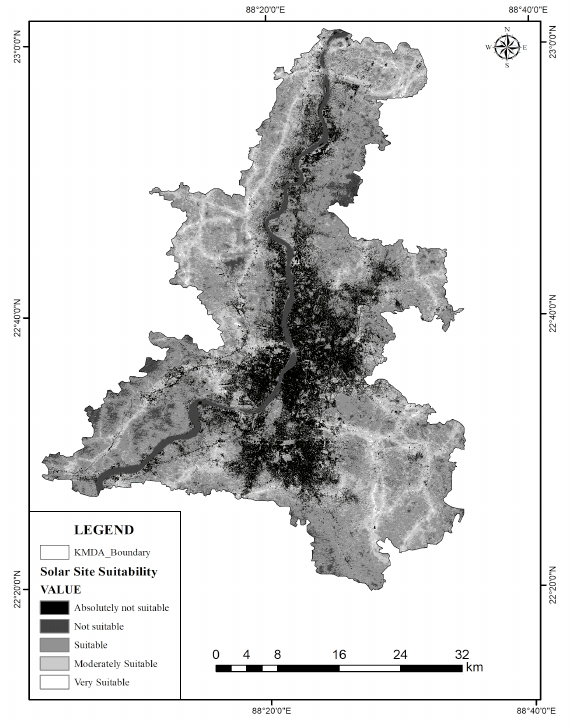
Figure 5 . Delineation of suitable zones for solar farm establishment in Kolkata Metropolitan Area,